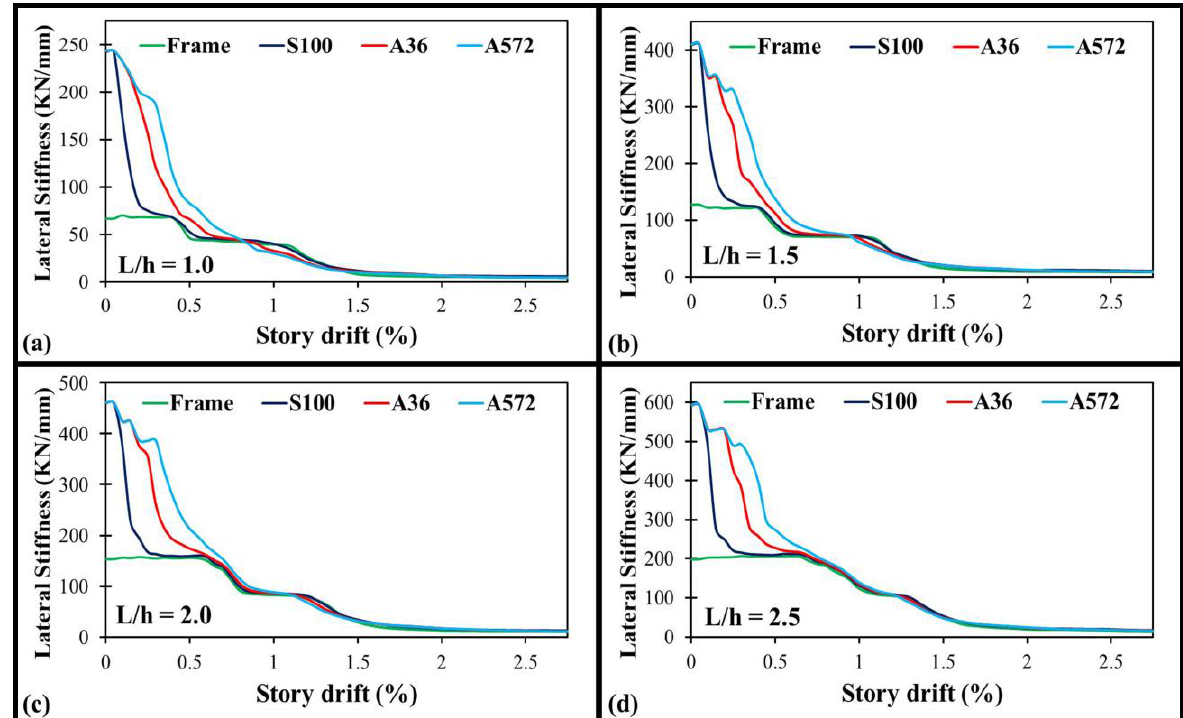
Fig. 11 . lateral stiffness of finite element models of SPSW and moment frame with different spans (3m, 4.5m, 6m, and